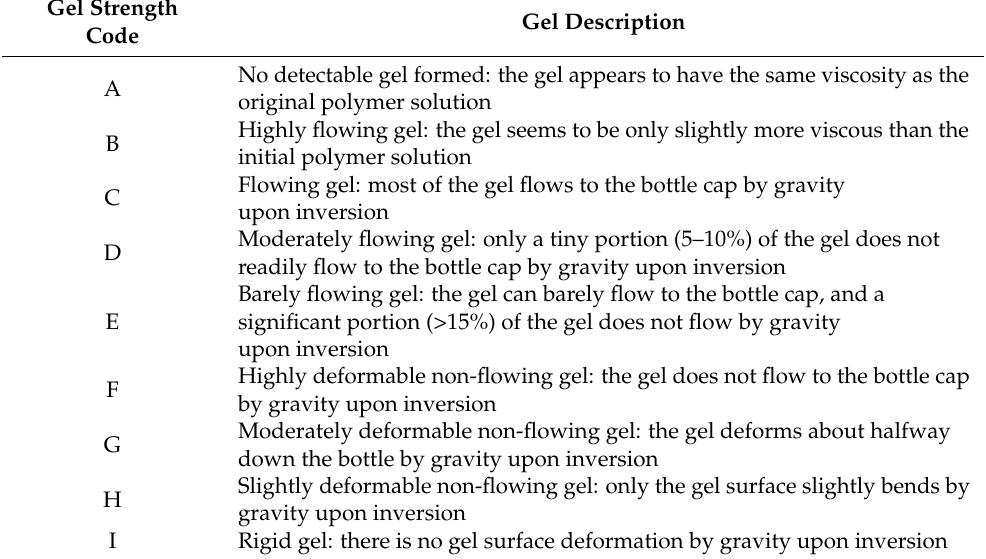
Table 1. Gel Strength